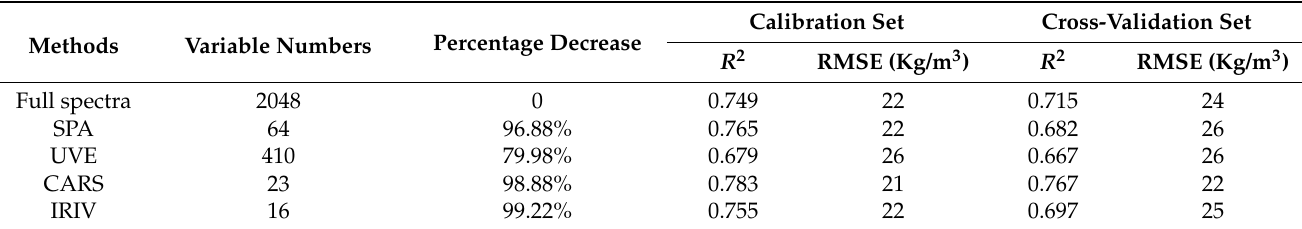
Table 2. The PLS models with various variable selection